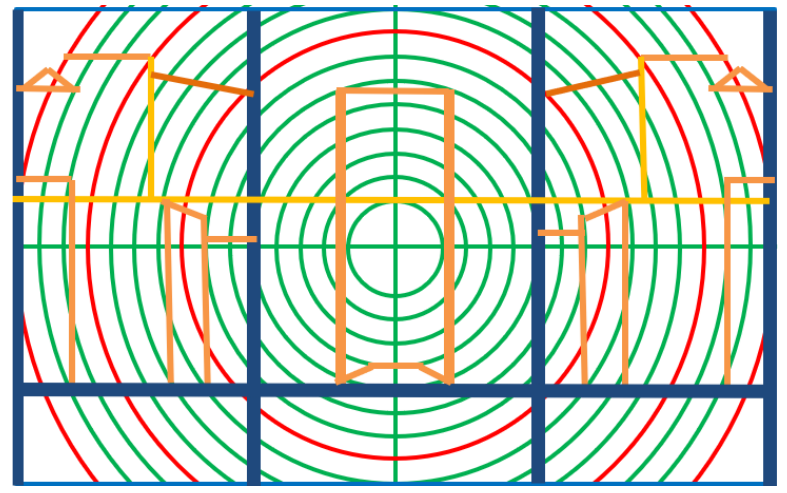
Figure 16. Upper structures added. Source: the author.